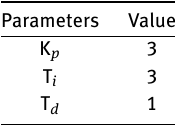
Table 5. Parameters value of PID controller